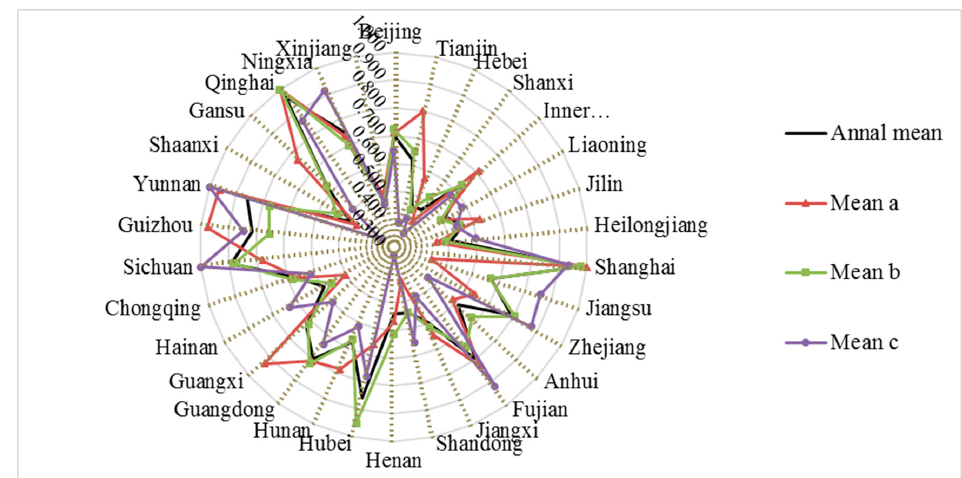
Figure 2. Annual average values of comprehensive level of environmental efficiency in power industry in China’s 30 provinces under different power reforms.